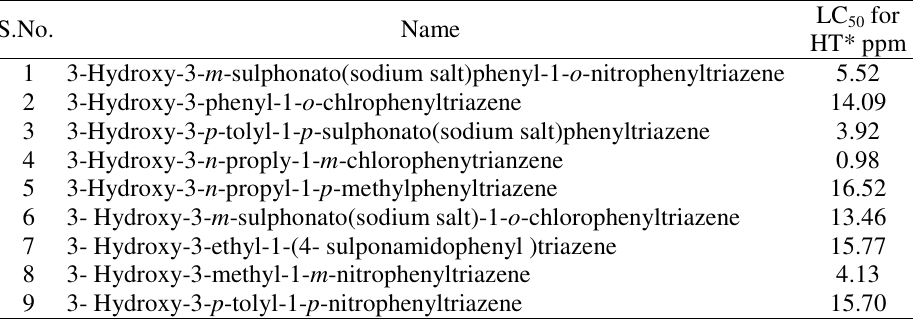
values and relative toxicity of hydroxytriazenes against D. melanogaster